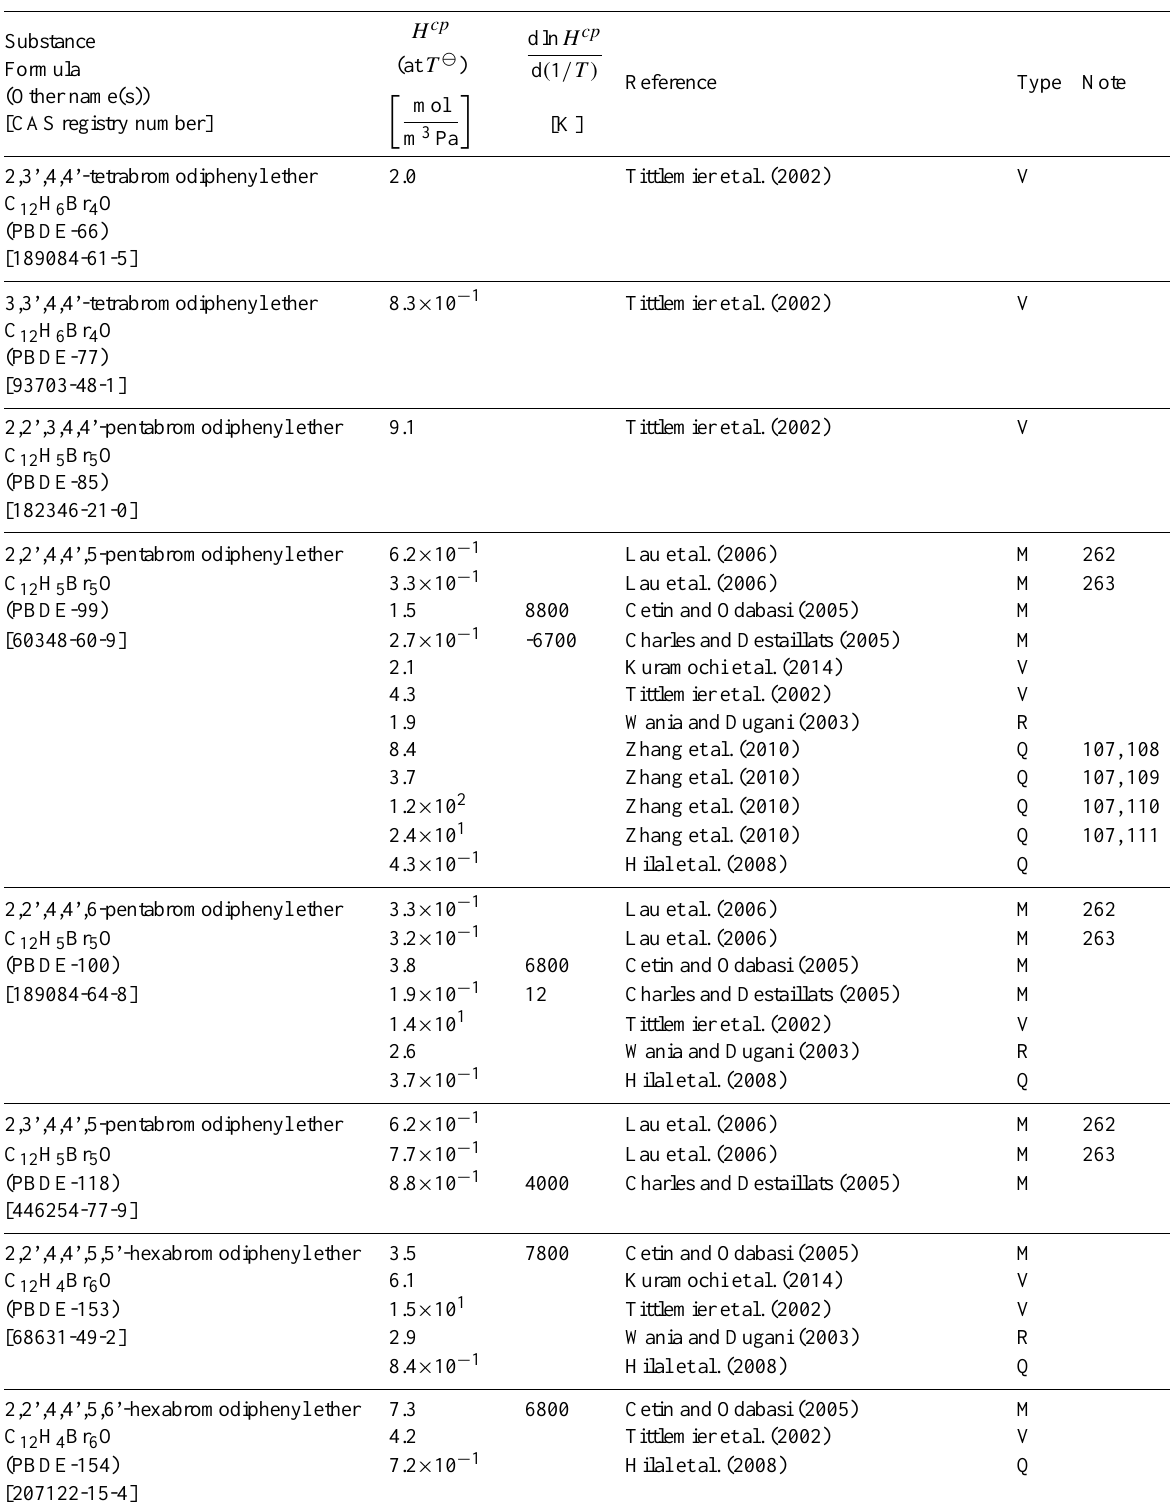
Table 6: Henry’s law constants for water as solvent